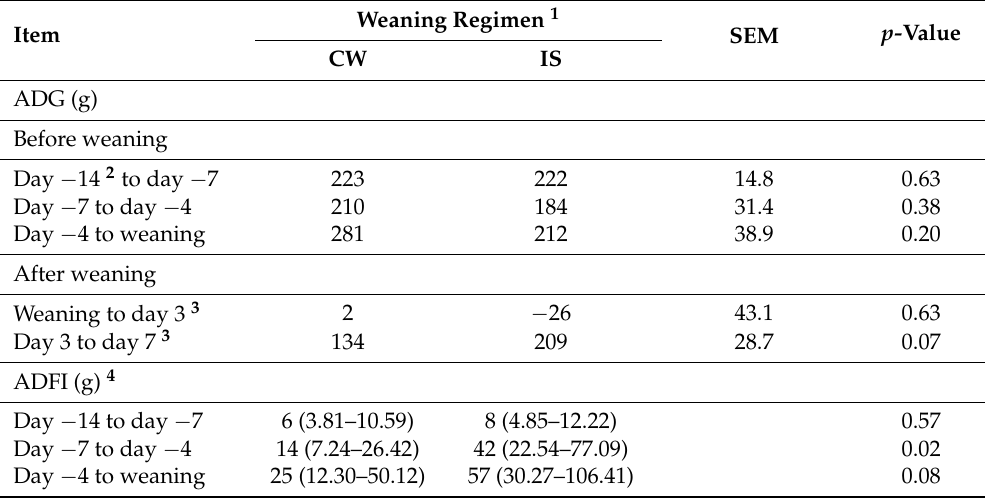
Table 2. Average daily gain (ADG) (grams per piglet) before and after weaning and average daily feed intake (ADFI) (grams per piglet) before weaning in two different weaning